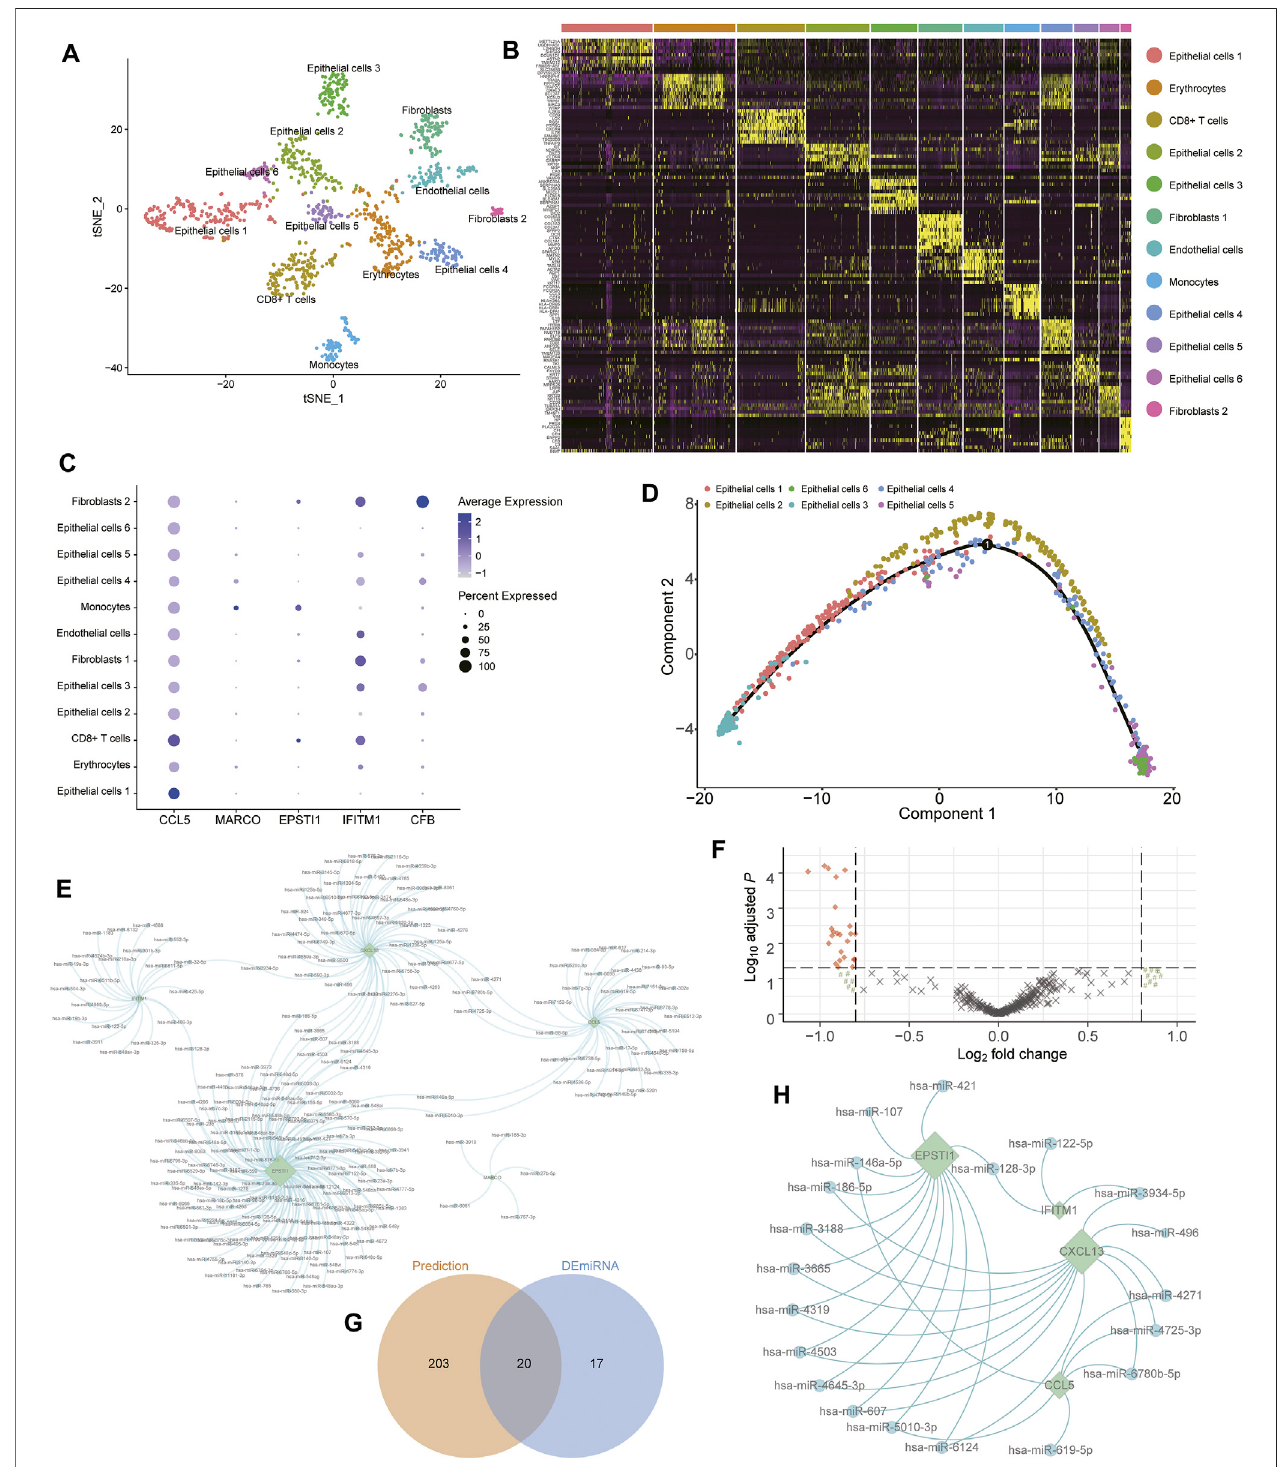
FIGURE 7 | Validation of cellular subtypes in TNBC through scRNA-seq analysis. (A) Visualization of tSNE colored according to cell types for TNBC single-cell transcriptomes. (B) Heatmap revealing the scaled expression of top 10 marker-genes for each cluster de fi ned in (A) . (C) Dot plots showing the expression of indicated Ps-score-relatedgenesforeachcellcluster. (D) MonoclepseudospacetrajectoryanalysisrevealingthecellularlineageprogressionofEpithelialcellssubtypesinpatients with TNBC colored according to different Epithelial cell clusters. (E) The miRNA-hub genes interaction network based on the prediction of four databases. The round node represented the miRNA and the rhomb represented the Ps-score-related genes. (F) Volcano plots displayed the upregulated and downregulated DEmiRNAs between two subgroups in patients with TNBC. (G) Venn diagram of the predicted miRNA and DEmiRNAs.